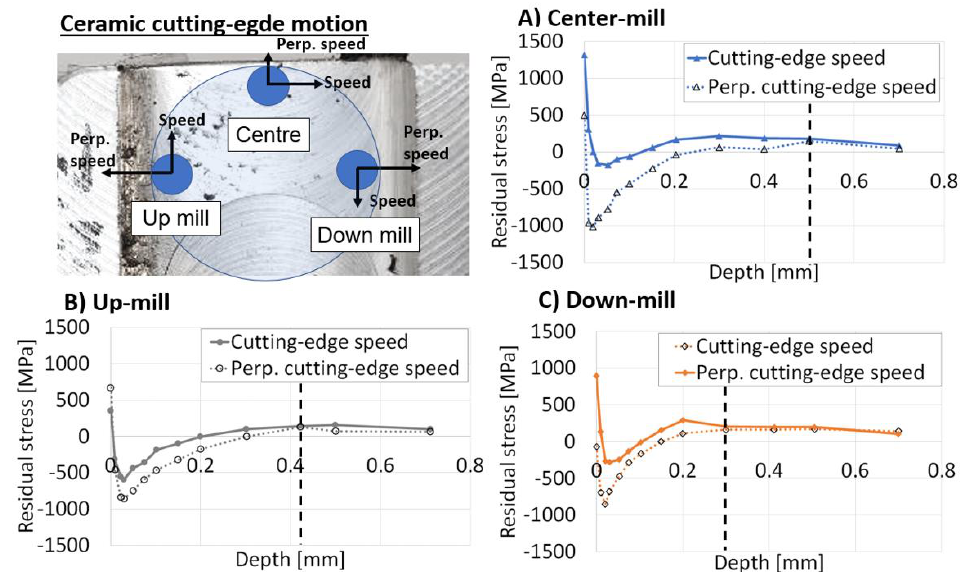
Figure 7. Residual stress profiles from surfaces machined with new ceramic insert at different po- sitions across the